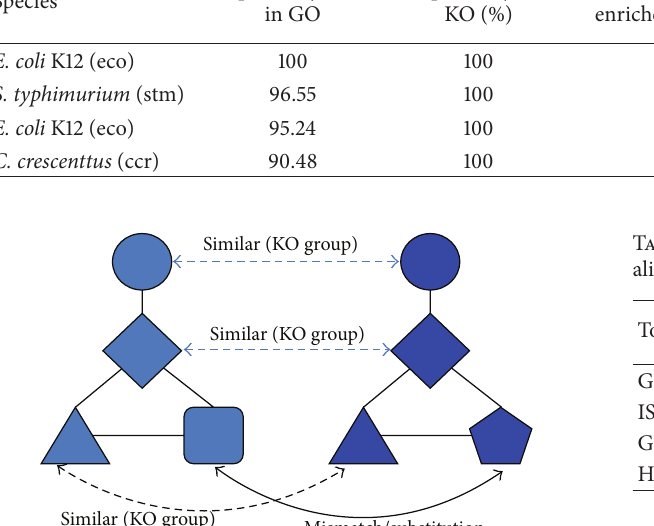
Table 6: Sensitivity comparison in terms of KO